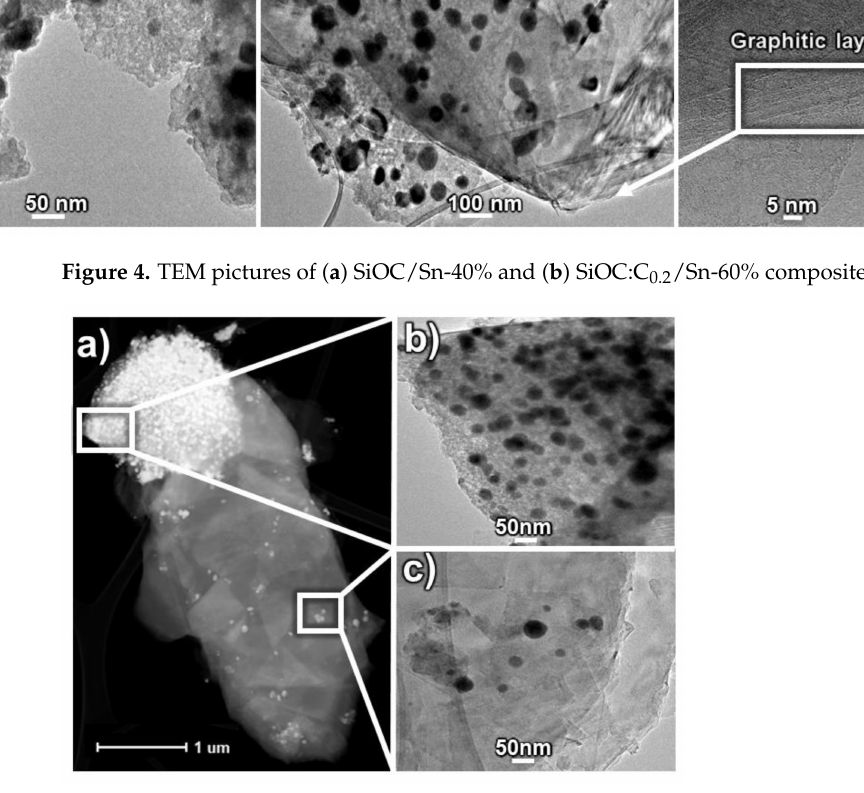
Figure 5. ( a ) HAADF image of a SiOC:C 0.2 /Sn-60% particle with separated ceramic and graphitic phases; TEM images of ( b ) ceramic phase and ( c ) graphitic